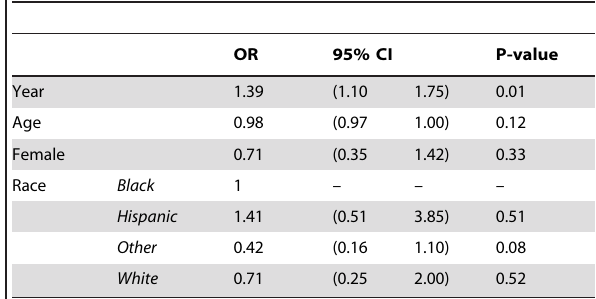
Table 4. Association of various demographic variables and likelihood of diagnosing a less severe disease